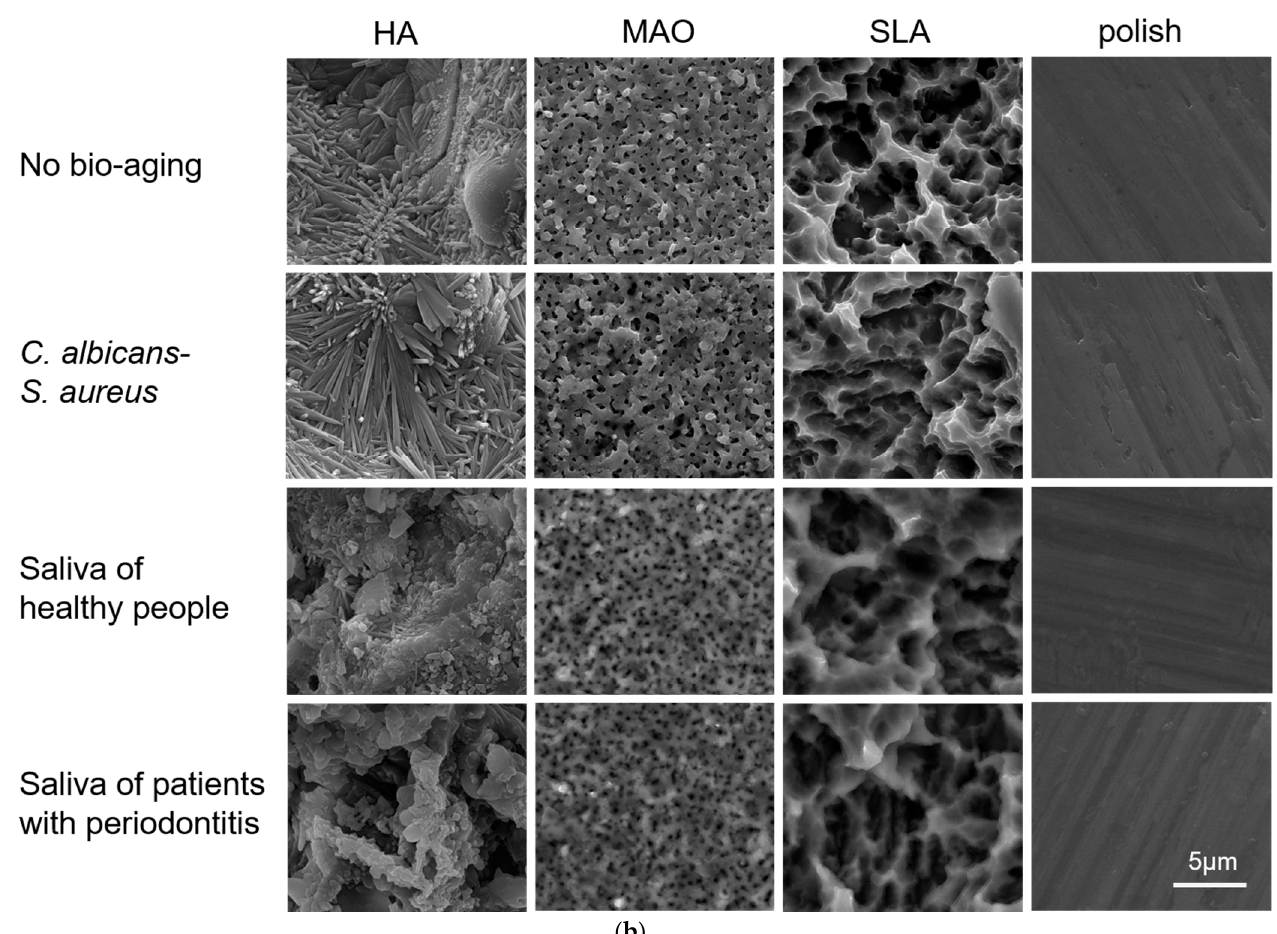
Figure 1. The surface morphology of samples as observed. ( a ) The gross morphology, such as color and morphology changes, were observed with a stereomicroscope; ( b ) The surface morphology is shown by SEM at a magnification of 20,000 ( n = 3). Representative images are shown here.